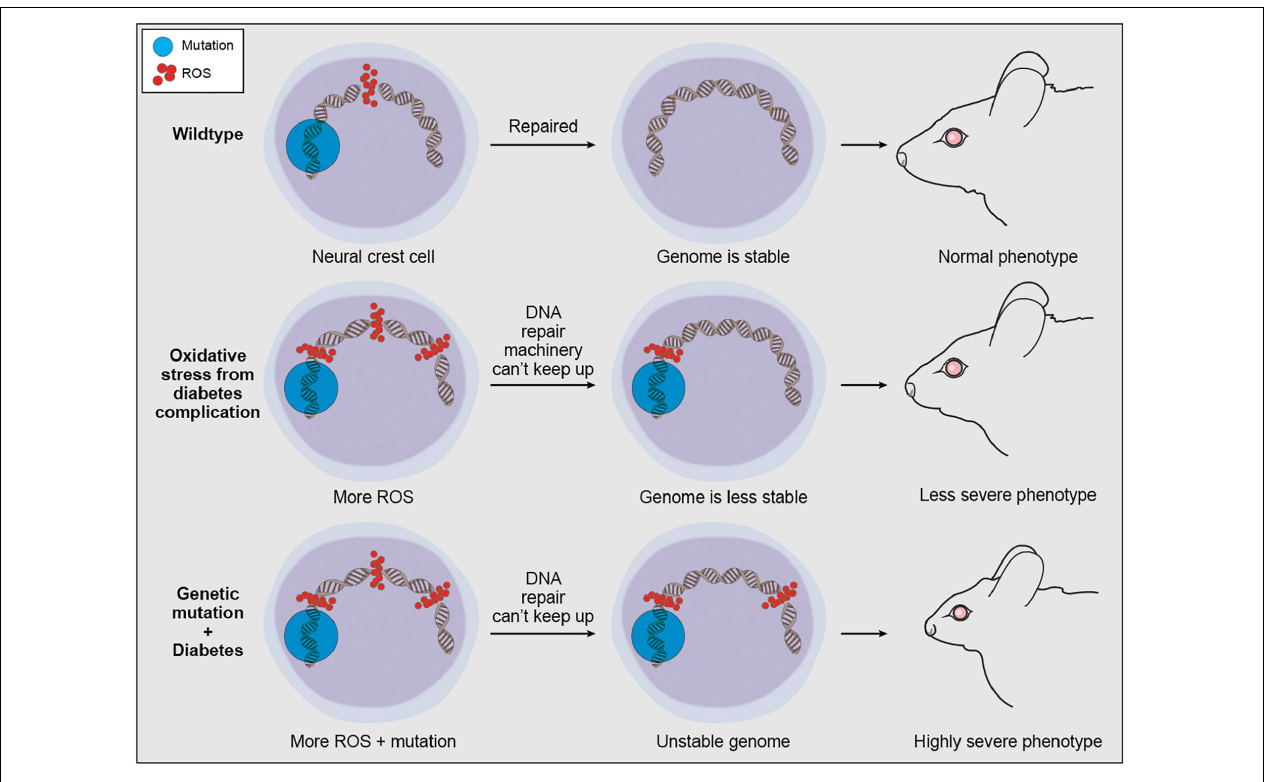
FIGURE 4 | Proposed mechanism of oxidative stress contribution to phenotypic variability in craniofacial anomalies. ROS is a natural byproduct of cellular metabolism which can be scavenged by antioxidant enzymes, and ROS-induced DNA damage within normal levels can be repaired by the DDR machinery. However, continuous exogenous or environmental oxidative stress can overwhelm antioxidant enzymes and DDR capacity, leaving some ROS-induced DNA damage unrepaired. This unrepaired DNA damage can compound the detrimental effects of genetic mutations associated with craniofacial